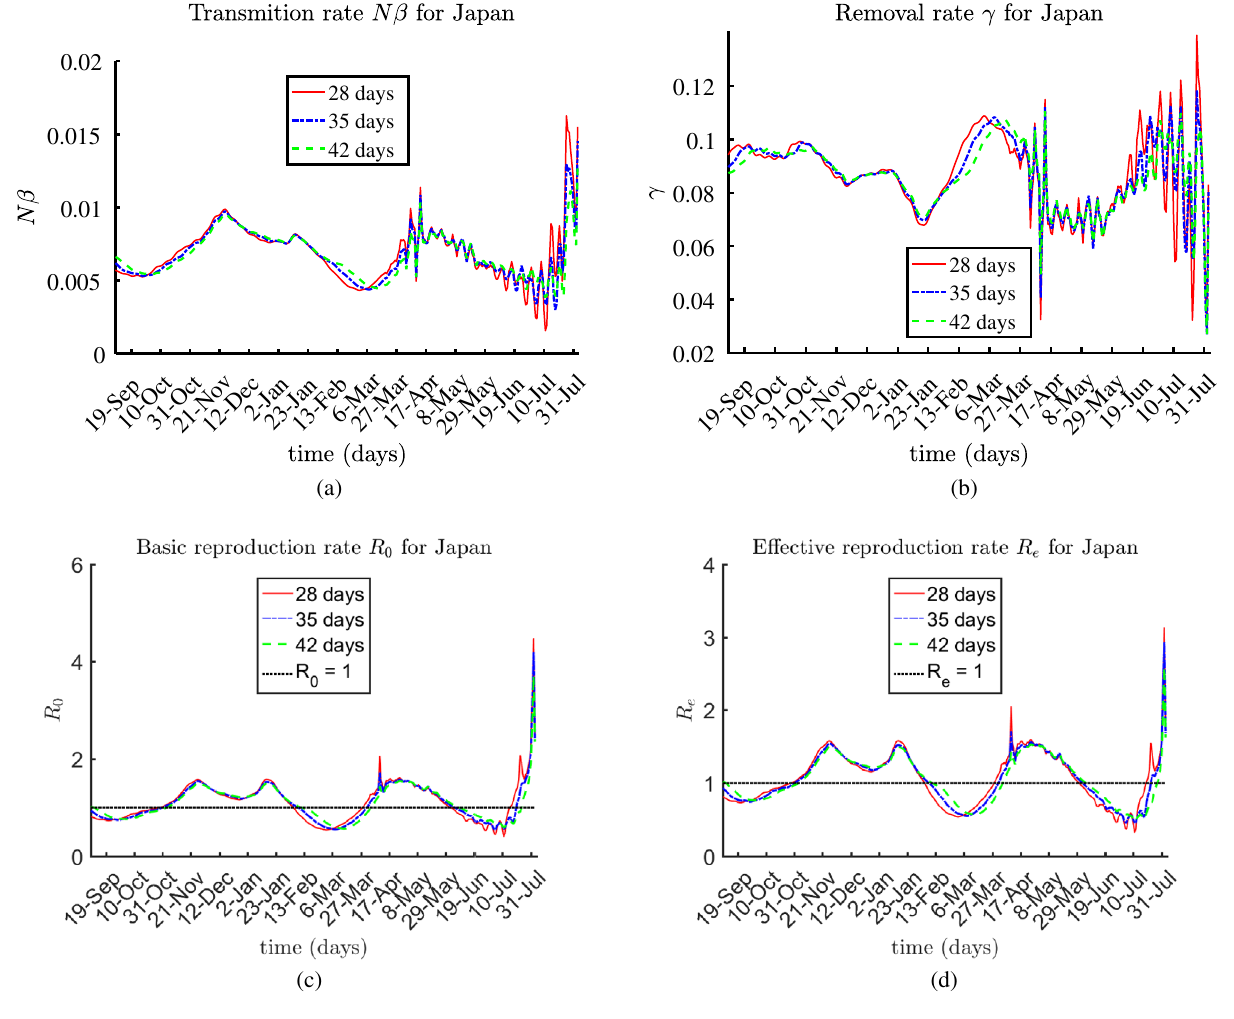
Figure 7. Estimated rates β N , γ , R 0 , and R e for